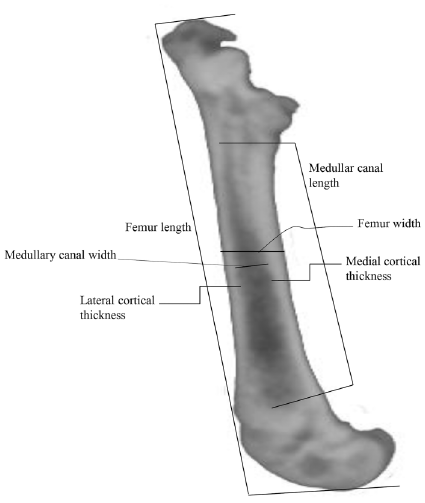
Figure 1. Radiographic lateral view of the femoral bone of a Wistar rat showing parameters measured in this study.